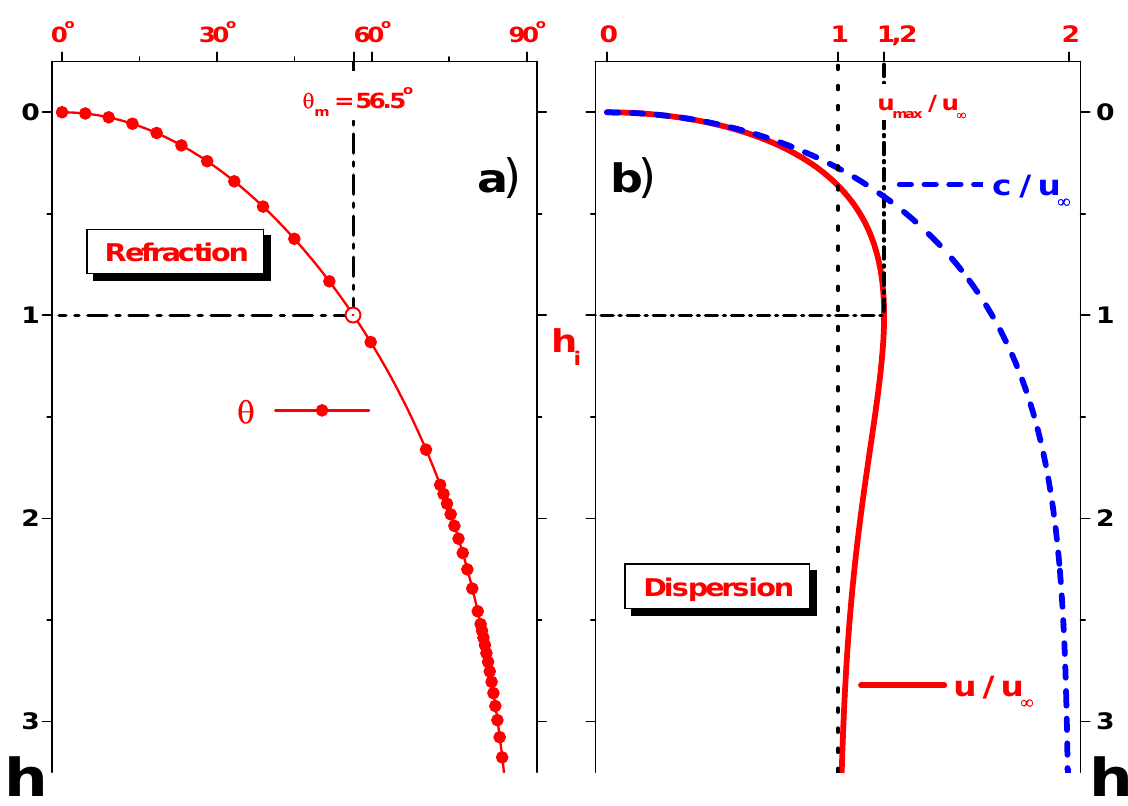
Figure 2. shows in panel a) the wave refraction angle θθθ as a function of the dimensionless depth hhh . The panel b) shows the behavior of the phase ccc and group uuu velocities as hhh varies. Note that uuu reaches a maximum value u max u max u max at h i ≡ 1 h i ≡ 1 h i ≡ 1 , and that around these intermediate waters ( d ≈ d i d ≈ d i d ≈ d i ) the wave refractive and dispersive effects are still very